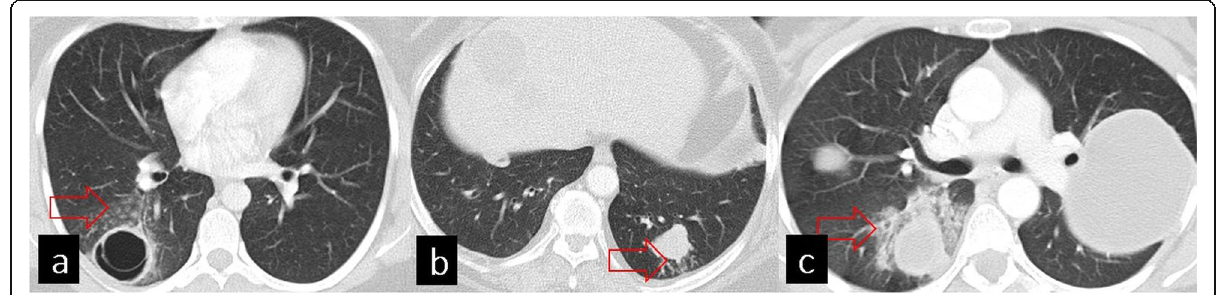
Fig. 7 Imaging features of hydatid cyst rupture directly to the lung parenchyma. Axial CT images of different patients showing centrilobular nodular opacities around the hydatic cyst ( a , red arrow), tree-in-bud pattern around the HC ( b , red arrow), and consolidation around the HC ( c , red arrow)